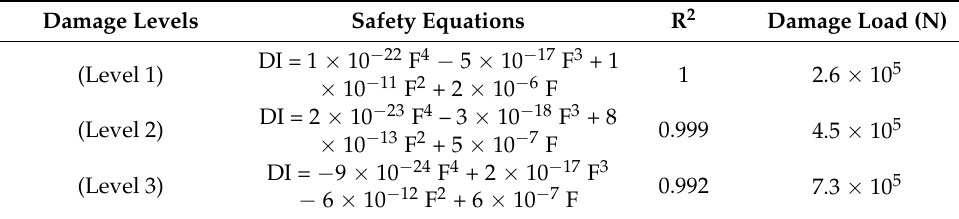
Figure 9. Damage Index (DI) variation for the first, second, and third DLs when water flow increases incrementally. Table 3. Safety equations, based on deformation concepts, for various levels of